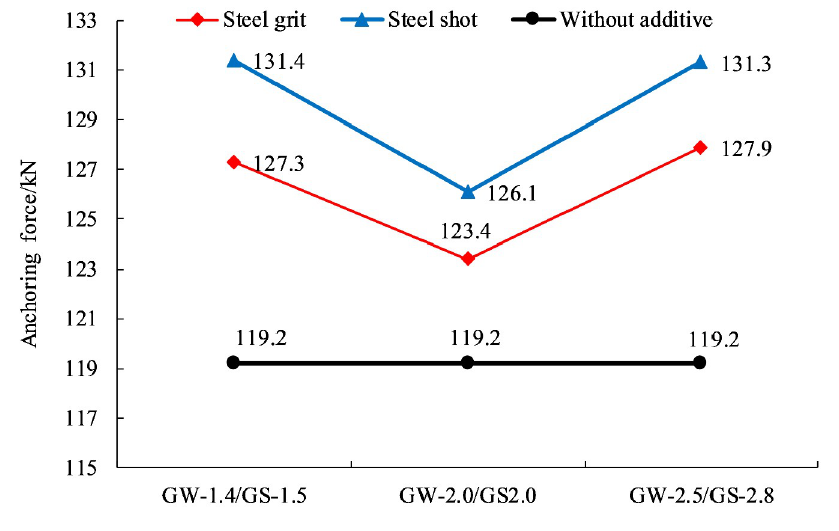
Fig 21. Effect of aggregate shape on anchoring